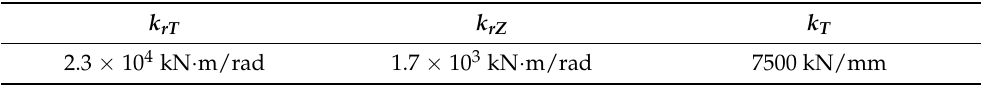
Table 3. Spring stiffness at the boundary of the T